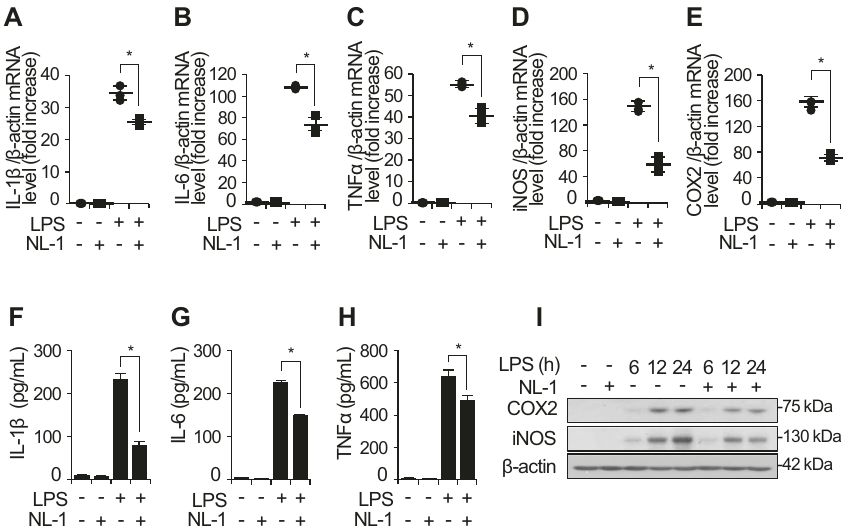
Fig. 2 Expression of in fl ammatory mediators decreases in the presence of the mitoNEET inhibitor NL-1. Total RNA, cell supernatants, and total protein were harvested from RAW264.7 cells 12 h (for mRNA) and 24 h (for protein) after treatment with vehicle, NL-1 (20 µM), LPS (100 ng/mL), or LPS plus NL-1 (20 µM). Levels of mRNA encoding pro-in fl ammatory mediators IL-1 β , IL-6, TNF α , iNOS, and COX2 were measured by quantitative real-time RT-PCR ( A – E ). Protein levels of pro-in fl ammatory mediators were analyzed using ELISA or western blotting ( F – I ). All data are presented as the mean ± SD from three independent experiments. *P < 0.05 for LPS vs. LPS plus